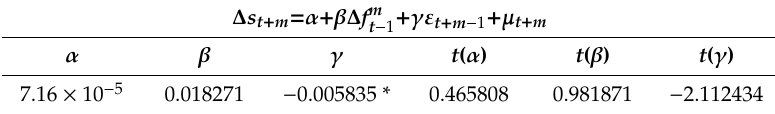
Table 8. Results of the error correction model (ECM).